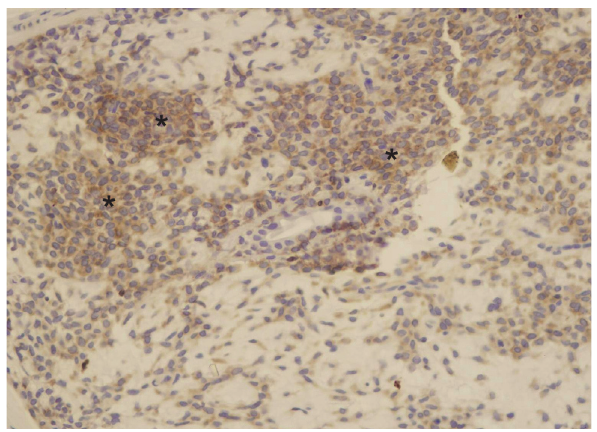
Fig. 3. Bcl-2 in intermediate cells. Moderate to strong bcl-2 immunoreaction of intermediate cells (asterisks) forming solid epithelial tumour areas. Original magnification, x 200.